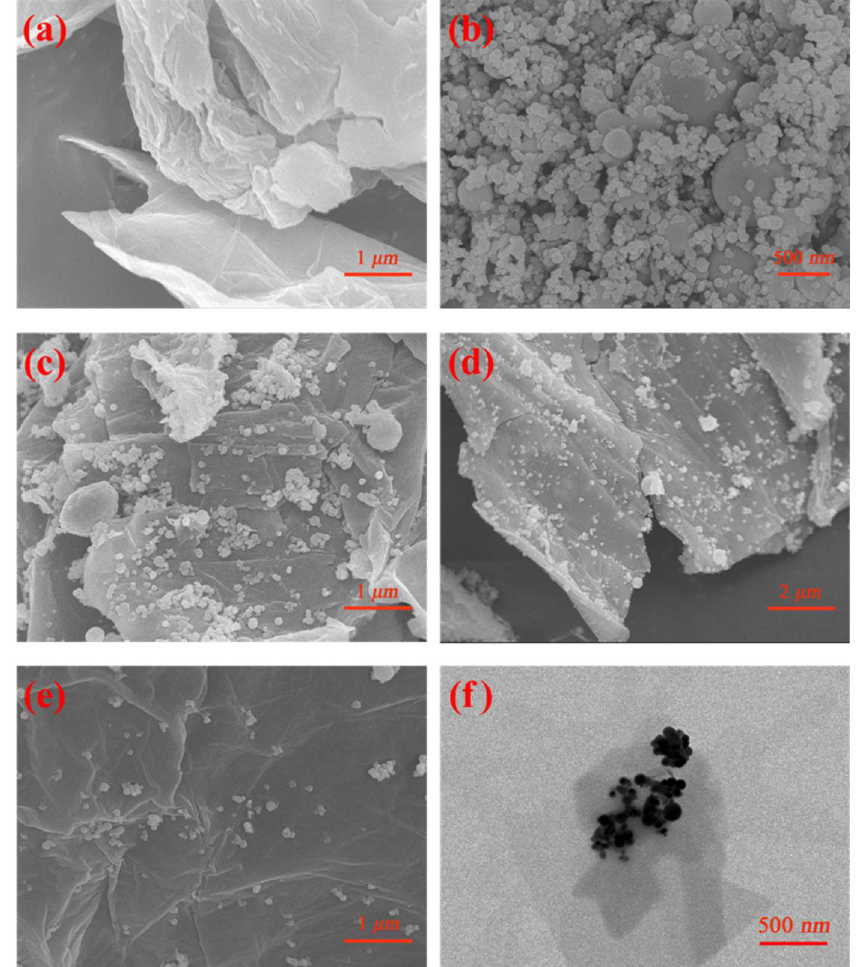
Figure 4. SEM images of ( a ) GO, ( b ) Nano-Ti particles, ( c ) GO-Ti(1:1), ( d ) GO-Ti(2:1), and ( e ) GO-Ti(3:1) composites. TEM image of ( f ) GO-Ti(2:1) composite.